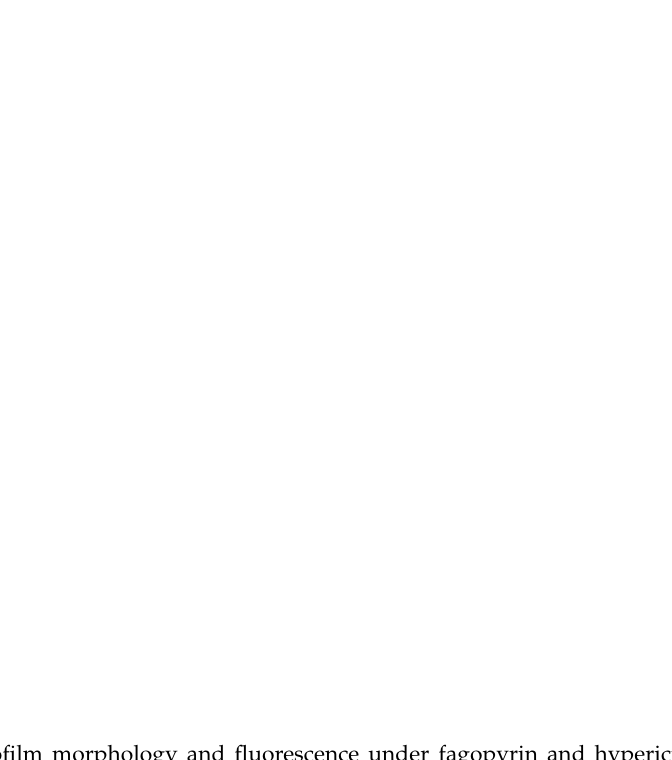
Figure 6. Alterations in biofilm morphology and fluorescence under fagopyrin and hypericin exposure. Planktonic growth for 24 h in YPD medium supplemented with fagopyrin (100 µM) (F), hypericin (100 µM) (H) or DMSO (C). The cells were imaged using bright-field (BF) microscopy and after laser excitation at 488 nm (FITC channel) with 100× objective. Table 1. Effect of fagopyrin and hypericin on colony features. Quantitative results expressed as means ± standard error of the mean (n = 6) from representative colonies grown for 15 days in YPD plates under different treatments: control (C, no photosensitizer), 100 µ M fagopyrin (F) and 100 µ M hypericin